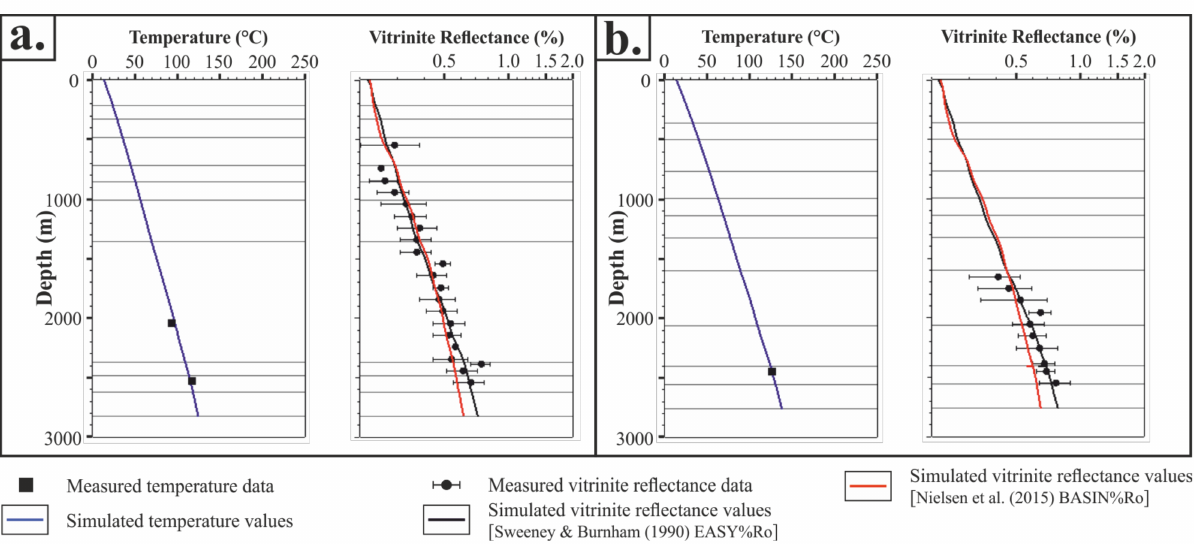
Figure 9. Temperature-depth and vitrinite reflectance-depth 1D extraction from the 2D basin models: ( a ) extraction of the W-09 well on the Section_01; ( b ) extraction of the W-53 well on the Section_01A. Extractions show a good fit between the simulated values and the measured data. Temperature- and vitrinite reflectance-depth plots show that the simulations were successfully